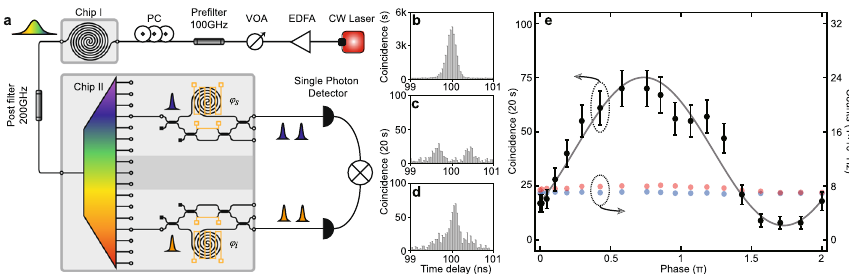
Fig. 3 Experimental setup and results for multi‑channel entanglement distribution of one sender and one receiver. a Experimental setup. A silicon‑on‑insulator waveguide on Chip I serves as a quantum source. Chip II is the energy‑time entanglement preparation and analysis chip. b-c Typical histograms of the interference peaks for CH11&CH7 of the AWG. The time resolution of the histograms is 40 ps. d The raw coincidence of the central peak for i 1 ‑s 1 changes with phase. The black dots are measured coincidences. The gray curve is obtained by fitting the measured results using the sine function. The error bar comes from the Poisson statistical distribution. Red and blue dots refer to single channel counts of idler and signal photons, respectively. PC: polarization controller; VOA: variable optical attenuator; EDFA: erbium‑doped fiber amplifier